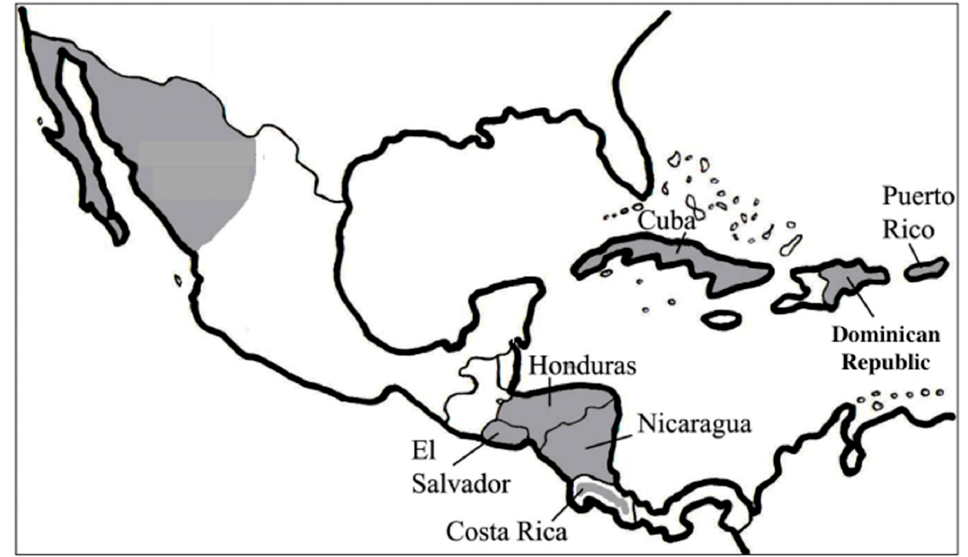
Figure 5. Jejeo distribution in Central-American Spanish (adapted from Rodríguez Prieto 2014).